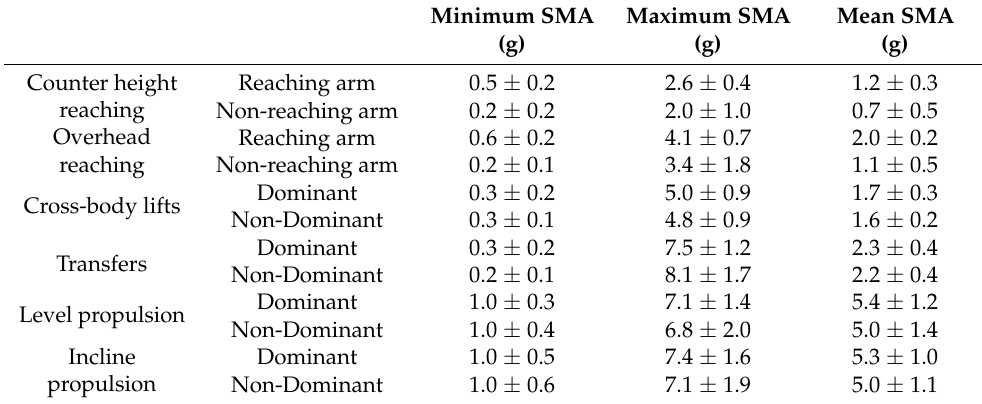
Table 2. The mean ± standard deviation of the minimum, maximum, and mean signal magnitude area (SMA) for the eight participants who completed the six in-lab manual wheelchair-based activities.